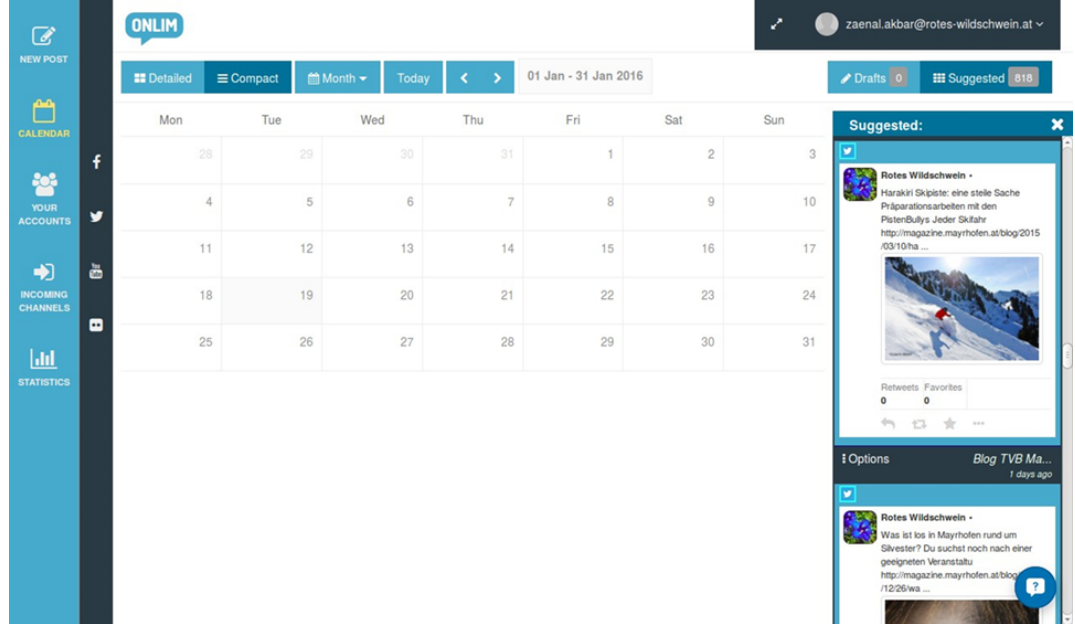
Figure 3. An example automatically-generated social media posts—hotel offer suggestions in Online Communication and Marketing Tool